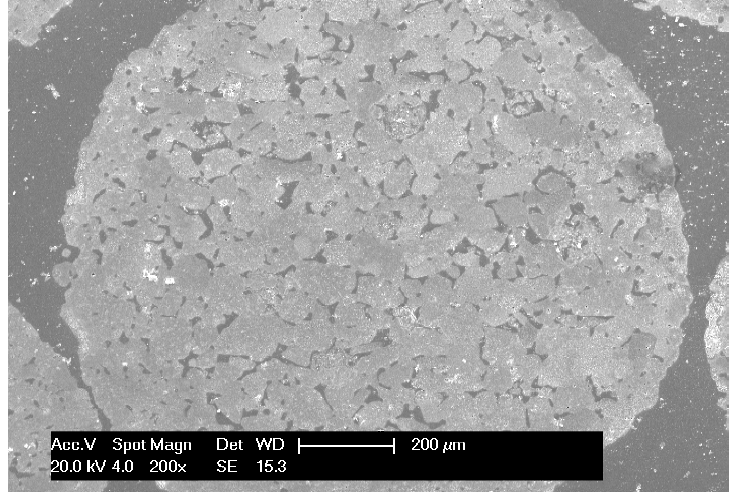
Figure 7. Cross section of a sintered salt bead showing internal